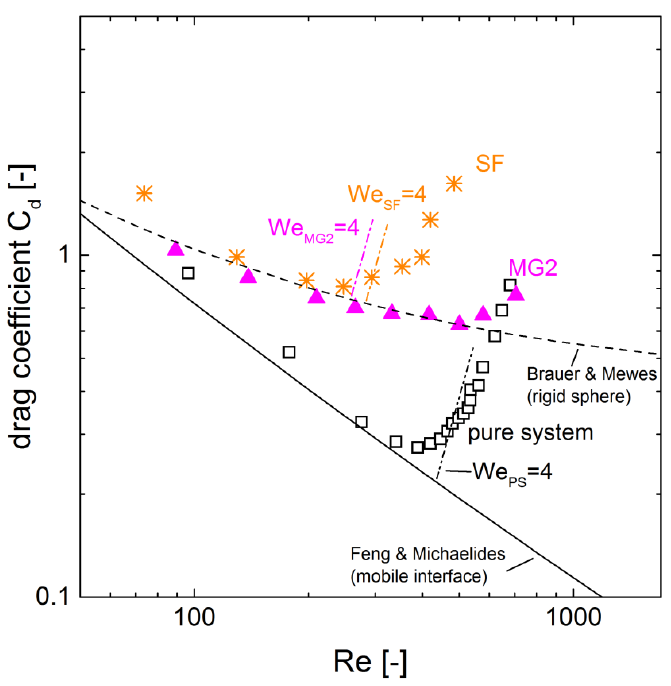
Figure 6. Drag coefficient as a function of the Reynolds number for the pure water/ n -butyl acetate system and the system containing MG2 and surfactant, respectively. The shown Weber number indicates the predicted onset of drop deformation. The development of the Weber number with increasing drop diameter is shown in more detail in Figure